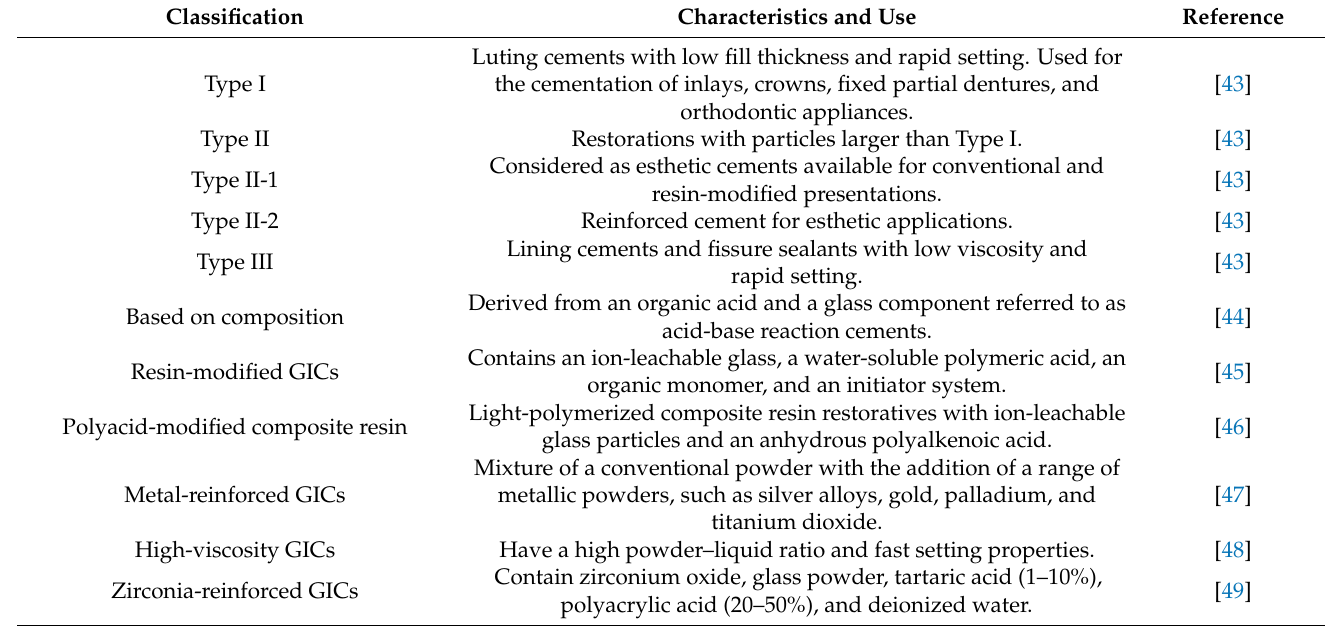
Table 1. Classification and characteristics of the glass ionomer cements.